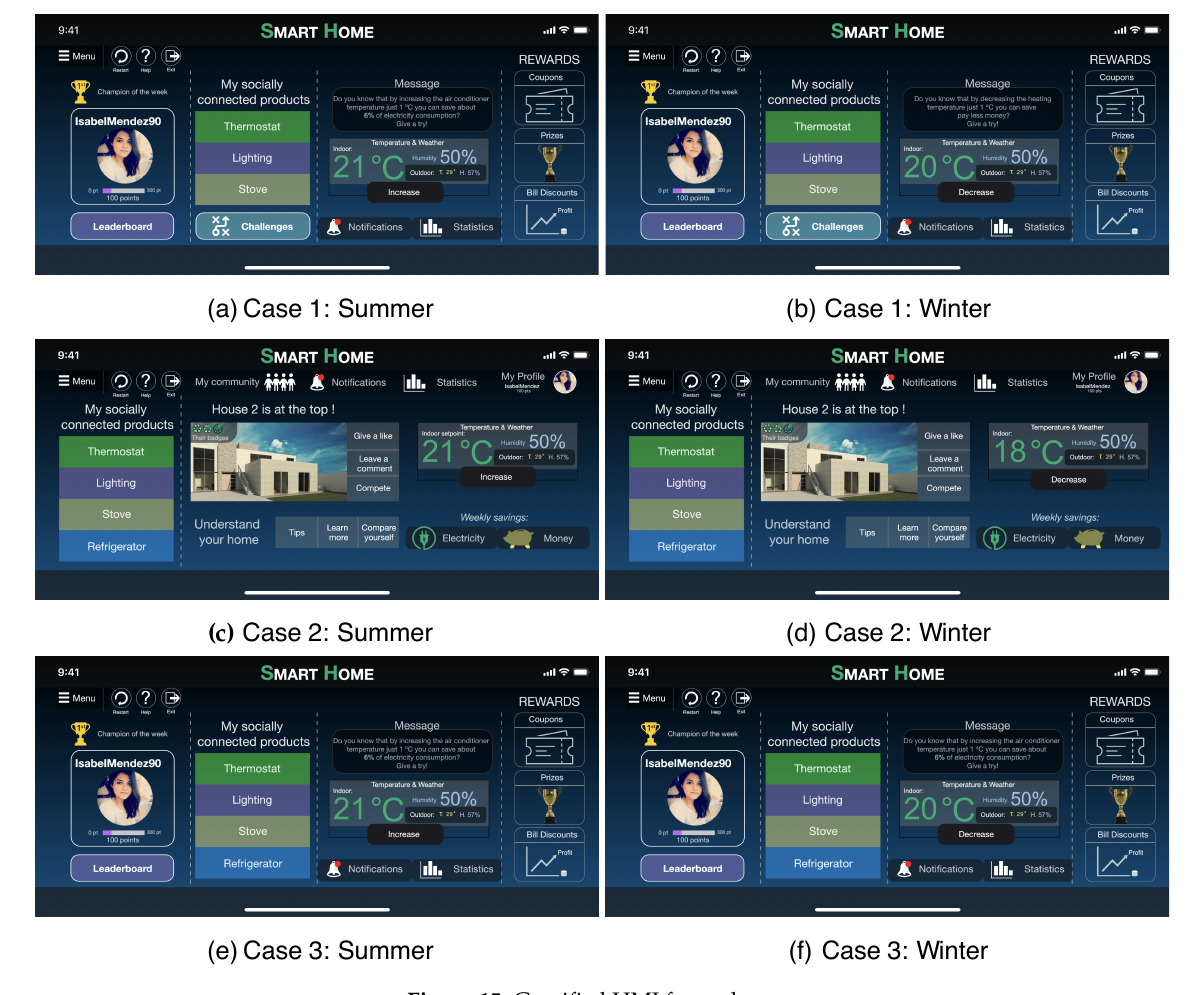
Figure 15. Gamified HMI for each